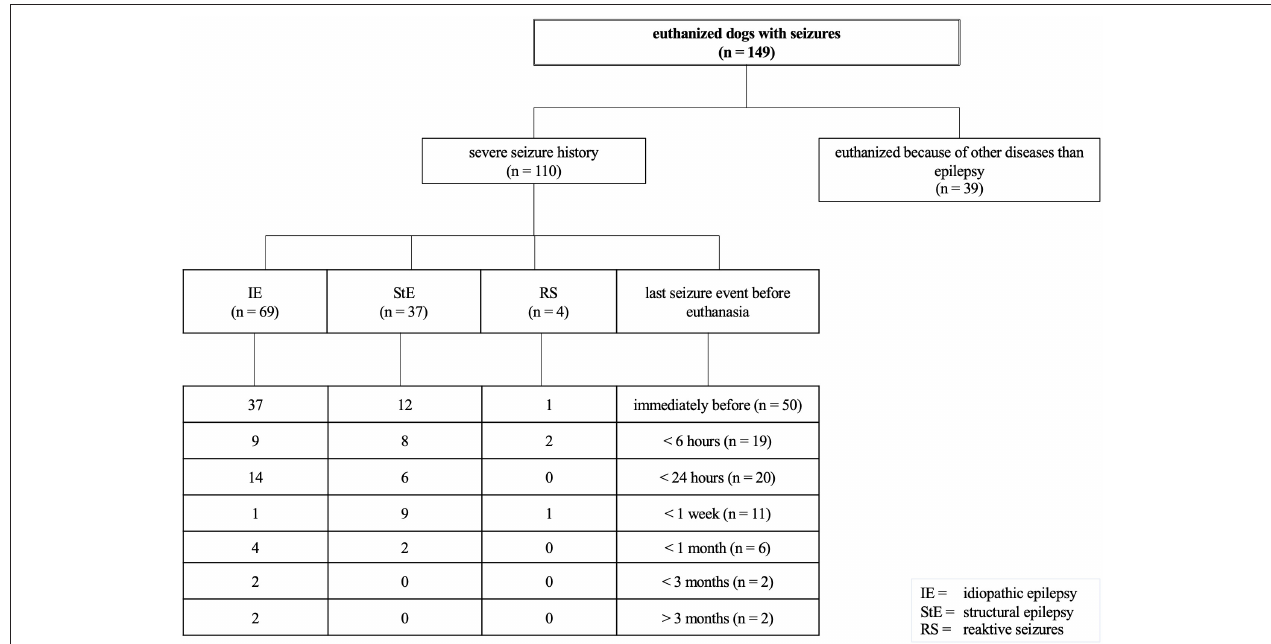
FIGURE 3 | Breed distribution of dogs with idiopathic epilepsy (IE) deceased from probable sudden unexpected death in dogs with epilepsy (pSUDED); A p < 0.05 was considered to be significant. The percentage of breeds in the whole study population, dogs with IE, and dogs with pSUDED is presented. Labrador and Golden Retriever were considered as the most represented breeds in this study. Dogs with brachycephalic syndrome were overrepresented (3/12) in the pSUDED group and a odds ratio of 3.68 was